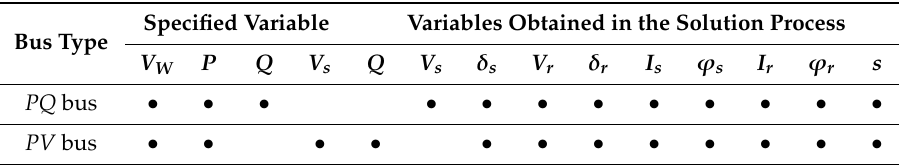
Table 1. PQ and PV methods for Wind Turbines based on